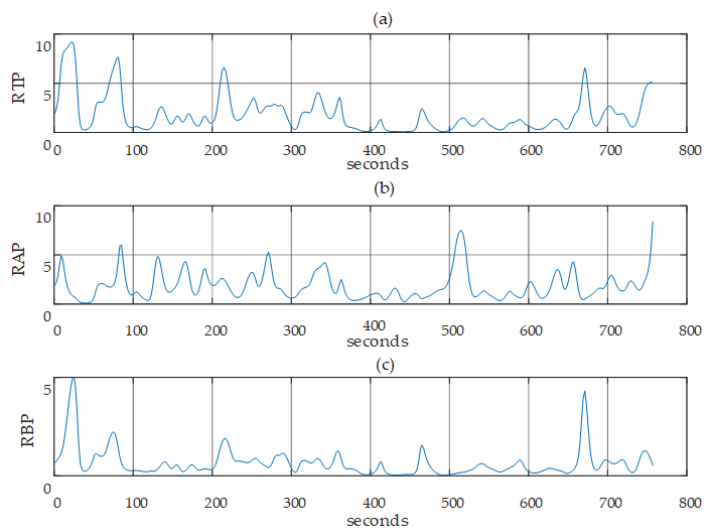
Figure 9. Example of ratios obtained from F4 electrode. ( a ) Theta–Beta Ratio, ( b ) Theta–Alpha Ratio, ( c ) Theta/(Alpha–Beta